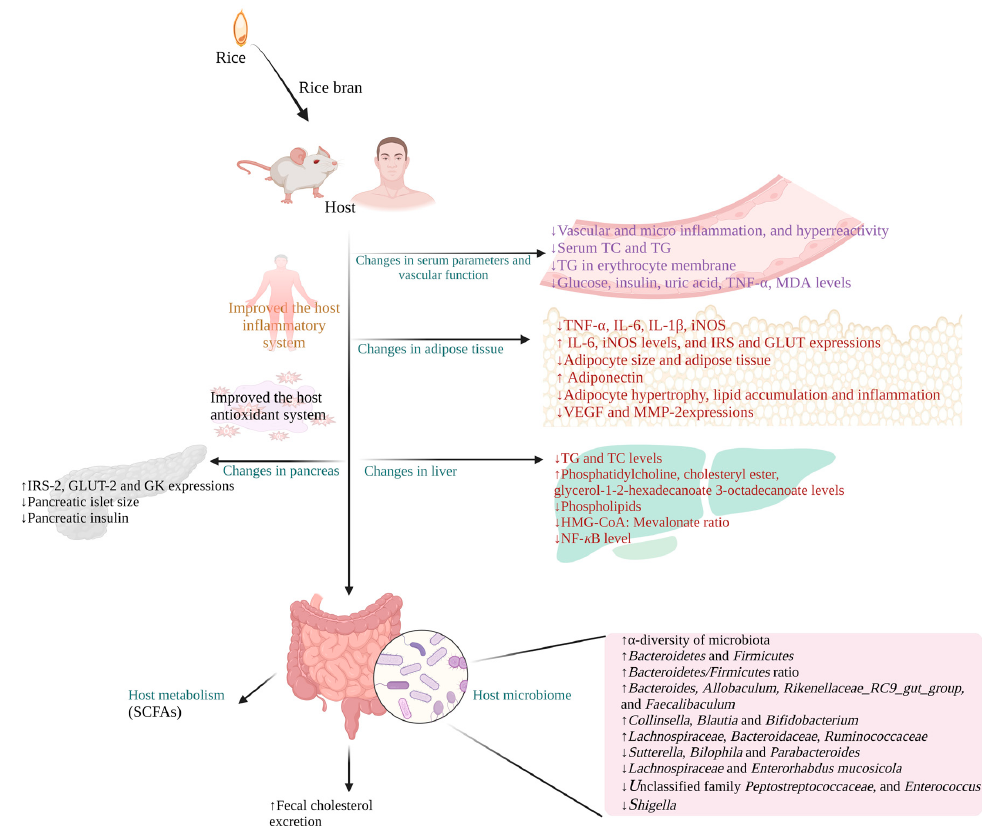
Figure 2. The possible mechanism underlying the anti-obese property of rice bran. Rice bran im- proves the host inflammatory and antioxidant systems and positively regulates the liver, pancreas, vascular functions, host metabolism, and host microbiome. Moreover, rice bran supplementation facilitates fecal cholesterol excretion. TC: Total cholesterol; TG: Triglycerides; TNF- α : Tumor necro- sis factor- α ; MDA: Malondialdehyde; IL-6: Interleukin-6; IL-1 β : Interleukin-1 β ; iNOS: Inducible ni- tric oxide synthase; IRS: Insulin receptor substrate; GLUT: Glucose transporter; VEGF: vascular en- dothelial growth factor; MMP-2: Matrix metalloprotease-2; HMG-CoA: 3-hydroxy-3-methylglutaryl coenzyme A; NF- κ B: Nuclear factor- κ B; GK: Glucokinase; SCFAs: Short-chain fatty acids; ↓ : De- crease; ↑ :